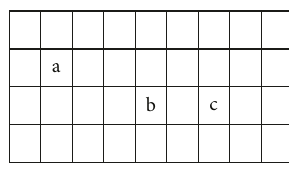
Figure 4: The divided regions of wind inlet boundary.